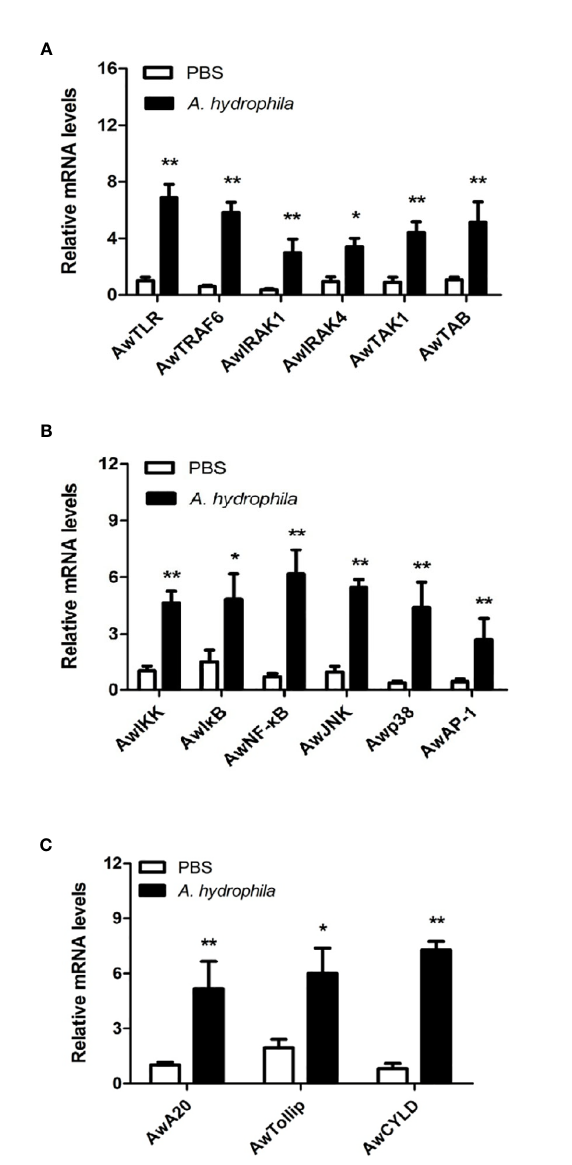
FIGURE 6 | Expression pro fi les of Aw MyD88 pathway signaling molecules (A, B) and negative regulatory proteins (C) in response to A. hydrophila challenge. The b -actin gene served as an internal reference gene to normalize the expression level. Each bar represents the mean of the normalized expression levels of the replicates ( N = 3). Signi fi cant differences between the immune challenge and control groups are indicated by the asterisks (* and ** represent P < 0.05 and P < 0.01,